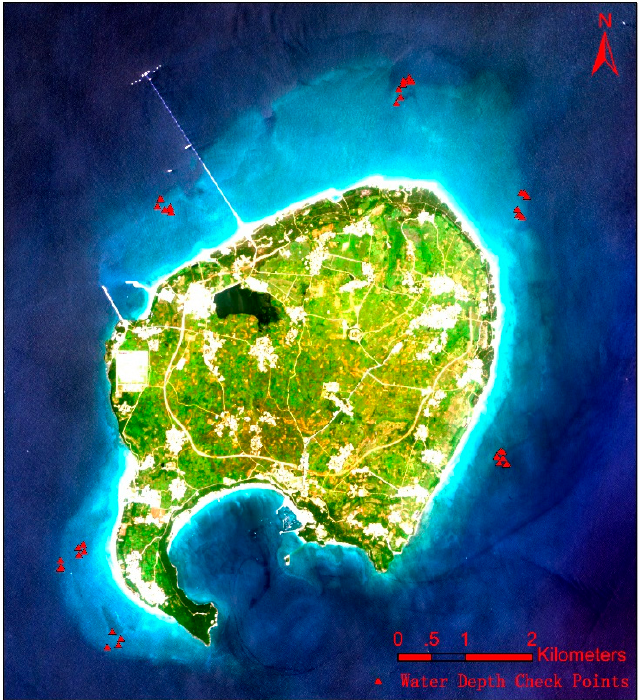
Figure 6. The position distribution of the measured water depths: the red triangles are the stations where the water depths were measured, these measured water depths are used as water depth check points for the accuracy assessment.